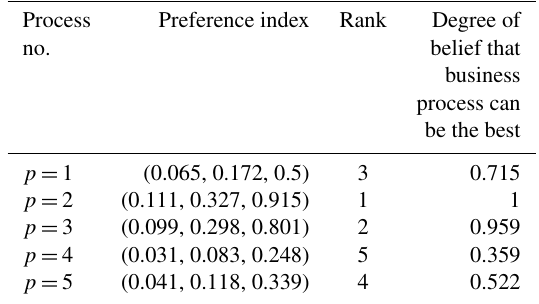
Table 7. The overall preference